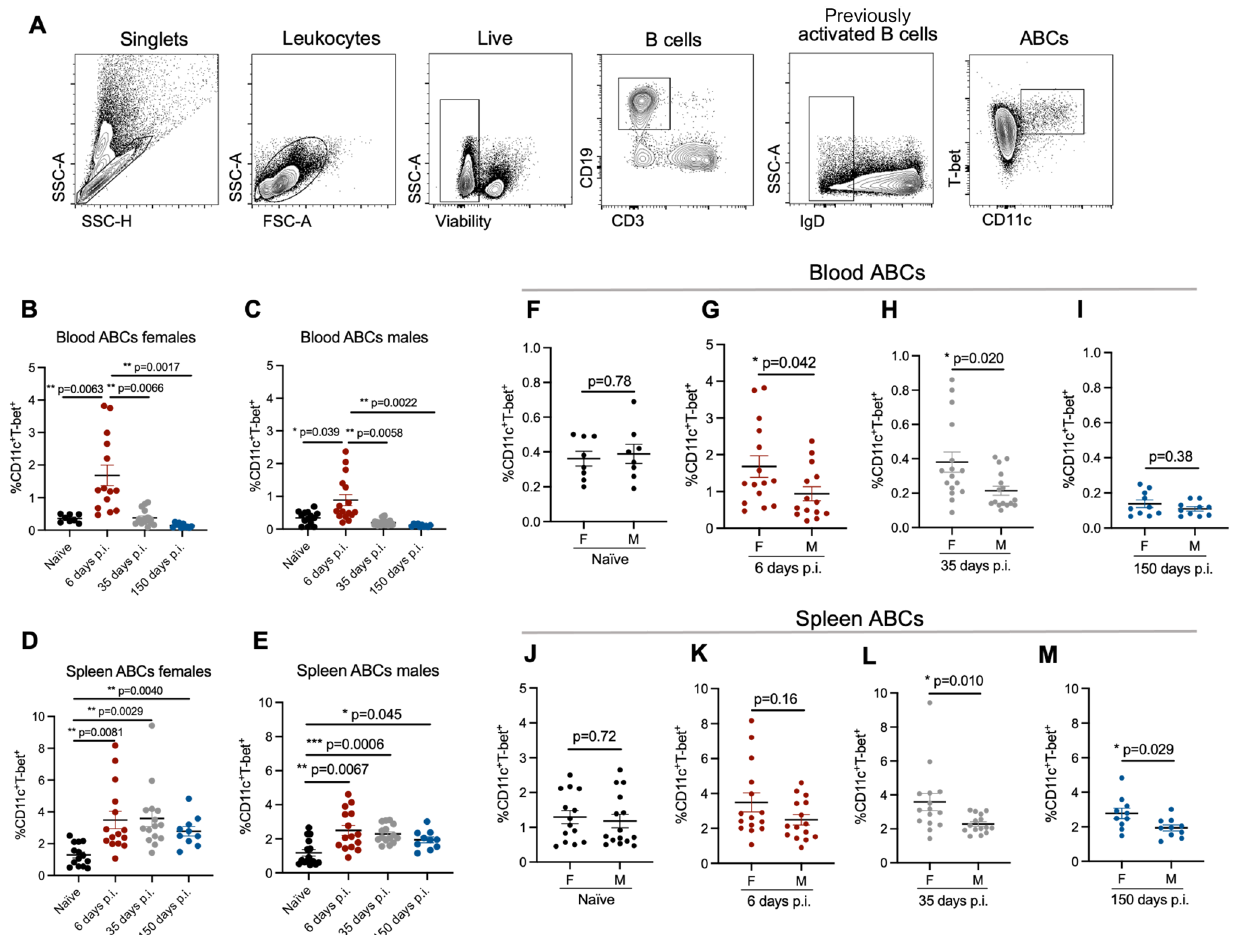
Figure 1. ABCs expand in the blood and spleen throughout γHV68 infection. Blood and spleen collected from C57BL/6(J) mice (6–8-week-old at infection) mock-infected with media (naïve, black circles) or infected i.p. with γHV68 for 6 (red circles), 35 (grey circles), or 150 (blue circles) days and processed for flow cytometry. ( A ) Representative gating strategy of ABCs. IgD, CD11c, and T-bet gating used fluorescence-minus-one (FMO) controls. ( B–E ) Proportion of ABCs (CD11c + T-bet + ) of previously activated B cells (CD19 + IgD − ) in the blood and spleen of male and female mice. ( F–I ) Proportion of ABCs (CD11c + T-bet + ) of previously activated B cells (CD19 + IgD − ) in the blood or spleen of male and female mice. Same data as presented in panels ( B–E ). n = 10–15 mice per group, data compiled from 4 experiments. Each data point represents an individual mouse. Data presented as mean ± SEM. Analyzed by ( B–E ) one-way ANOVA or ( F–M ) Mann–Whitney test. p-values indicated as asterixis as follows: ***p < 0.001, **p < 0.01, *p <